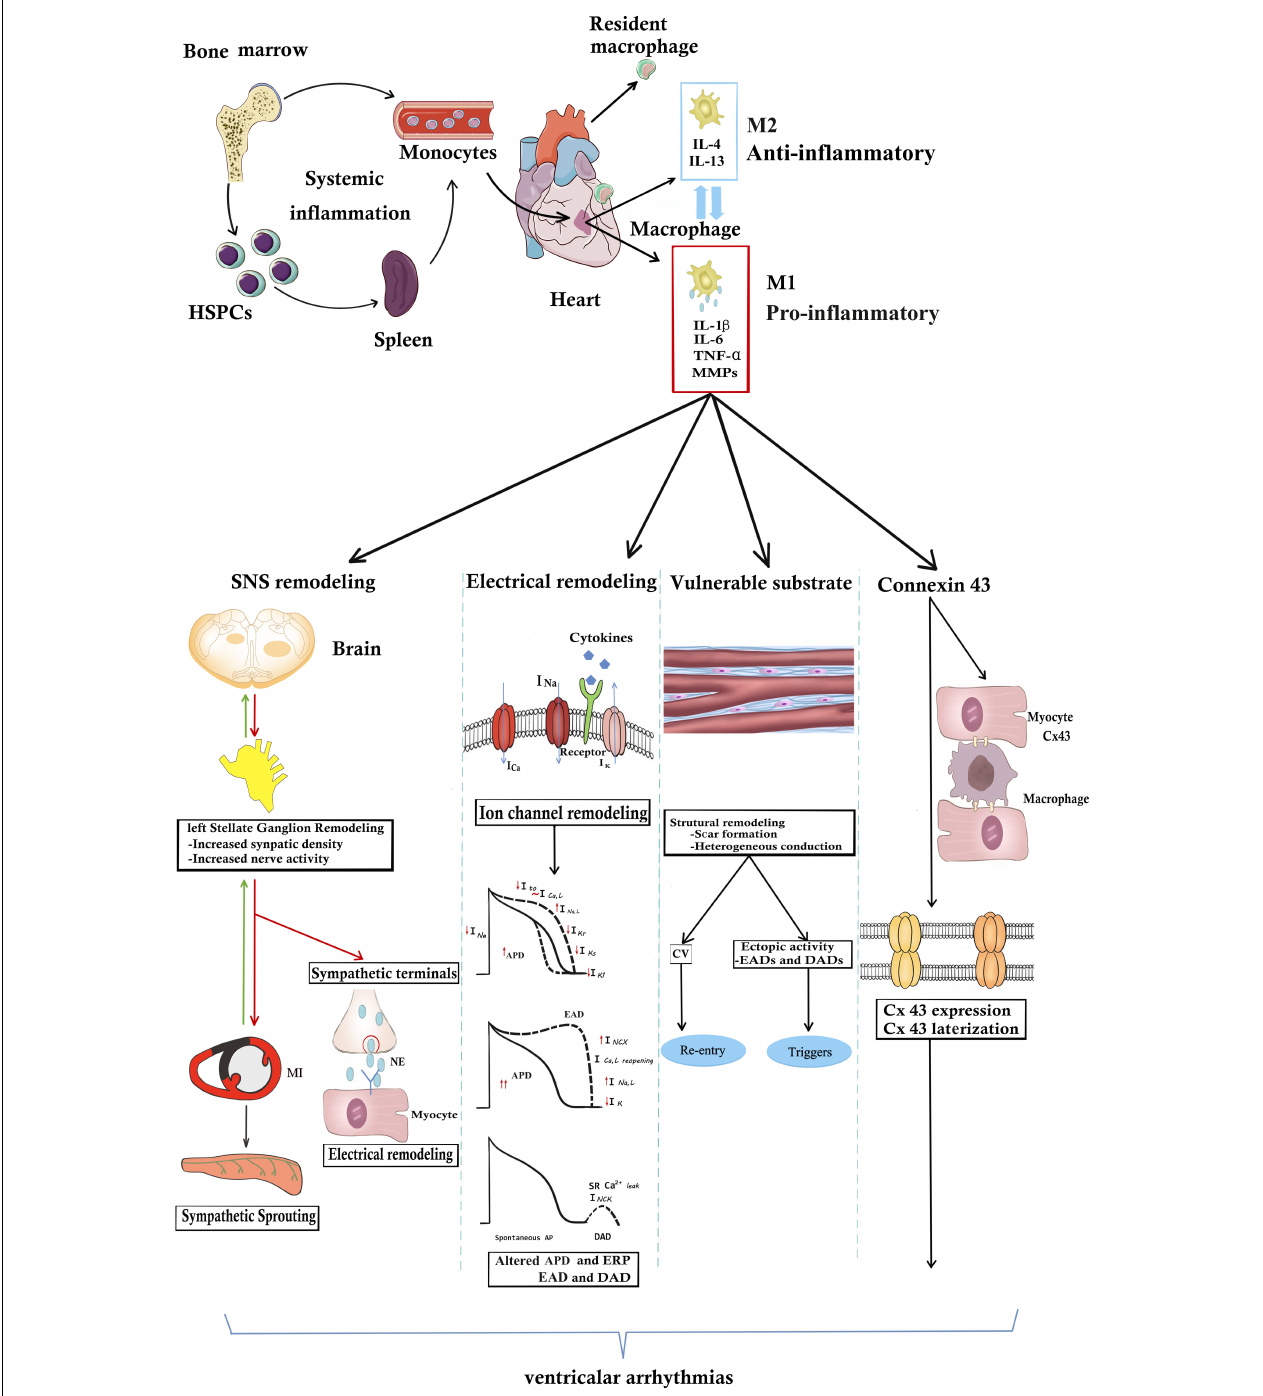
FIGURE 1 | The underlying mechanisms of macrophages or macrophage-related cytokines produce VAs. In the steady state, resident cardiac macrophages originate from the yolk sac and fetal liver progenitors. Following myocardial inflammation, blood monocytes derives from increased production in the bone marrow and spleen. Monocyte-derived macrophages generally are divided into M1 “inflammatory” macrophages and “anti-inflammatory” M2 macrophages. M1 macrophages secrete pro-inflammatory cytokines including IL-1 β , TNF- α , IL-6, and MMP-9. Macrophages or macrophage-related cytokines induce the occurrence of VAs through the following four pathways. (1) Inflammation increases afferent nerve traffic and then leads to anatomic remodeling within the left stellates ganglion remodeling and sympathetic sprouting. NE released from sympathetic terminals changes ventricular electrophysiology. SNS remodeling and over-activated sympathetic tone increase the propensity for cardiac VAs. However, in turn sympathetic tone aggravates macrophage activation. (2) Arrhythmogenic electrophysiological remodeling. Cytokines bind to the receptors and lead to ion channel remodeling, finally resulting in APD prolongation and ERP shorting.